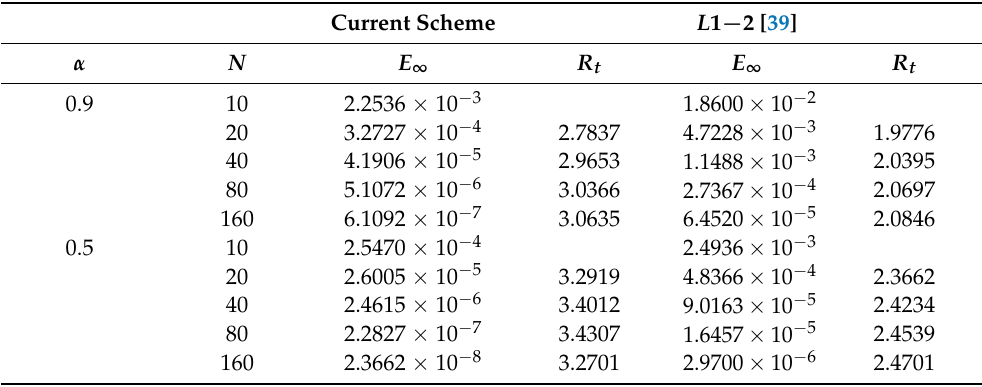
Table 7. The maximum errors and convergence rates R t of Example 4.1 in [39] (page no 43) for different values of α with h =